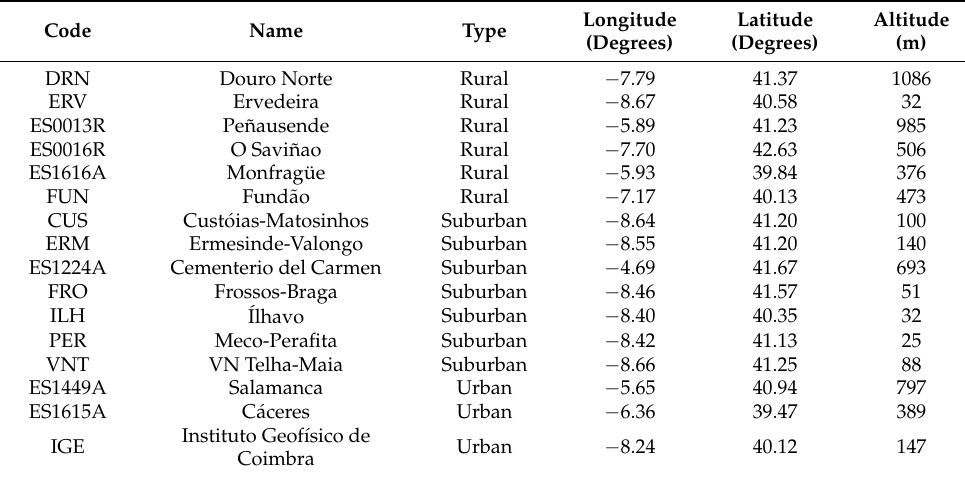
Table 3. List of stations used in model validation and its characteristics.